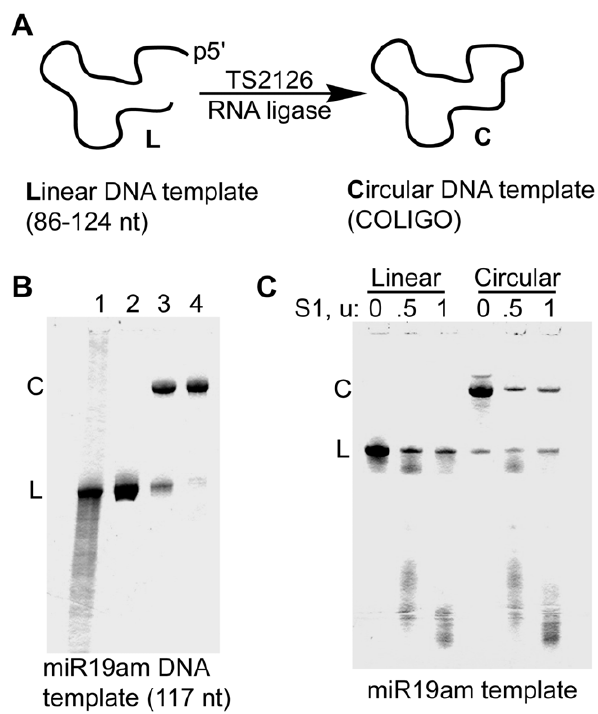
Figure 2. Circularization of DNA templates (COLIGOs) for Rolling Circle Transcription. A . Synthetic 5 9 phosphorylated linear DNA sequences were circularized using the thermostable TS2126 RNA ligase. B . Denaturing polyacrylamide gel electrophoresis (DPAGE) at four stages during miR-19am DNA circle synthesis. Lane 1, crude DNA IDT Ultramer synthesis of COLIGO 19am. Lane 2, after preparative DPAGE. Lane 3, crude circularization product. Lane 4, DNA circle template following Exonuclease I clean-up. Visualization using Stains- All. C . Verification of circular topology. Nicking of circular templates by S1 nuclease leads first to linear forms, which are then further digested to successively smaller linear forms.